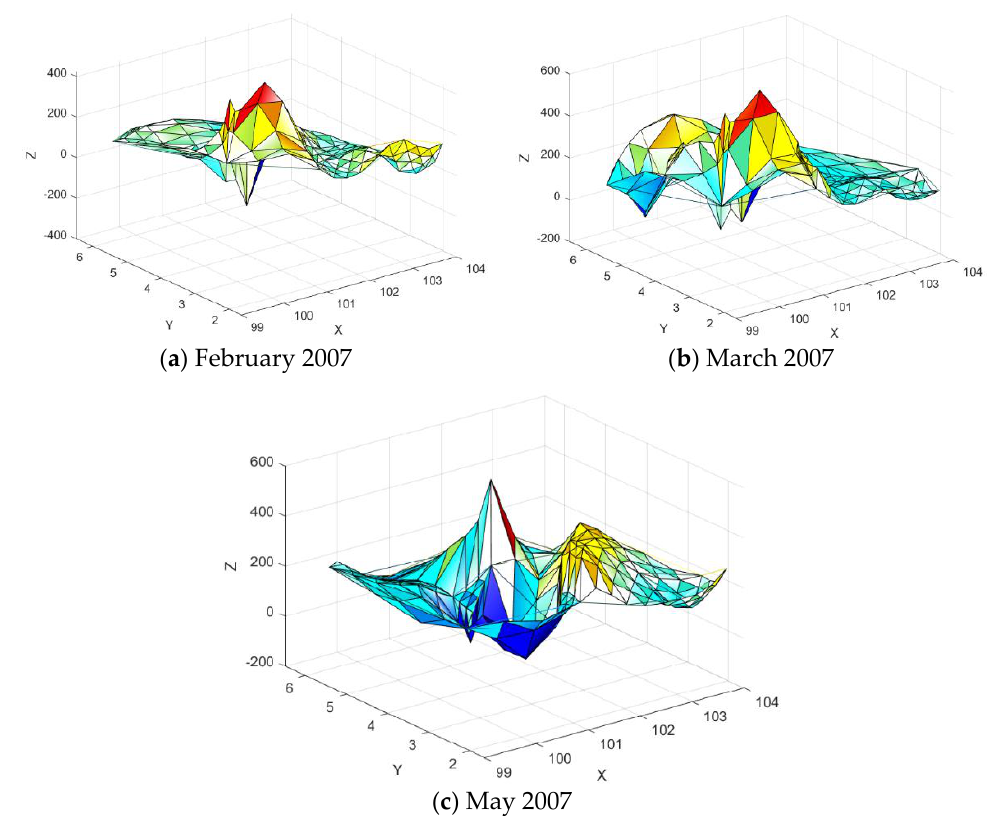
Figure 29. 3D Linear Interpolant of the rainfall data.